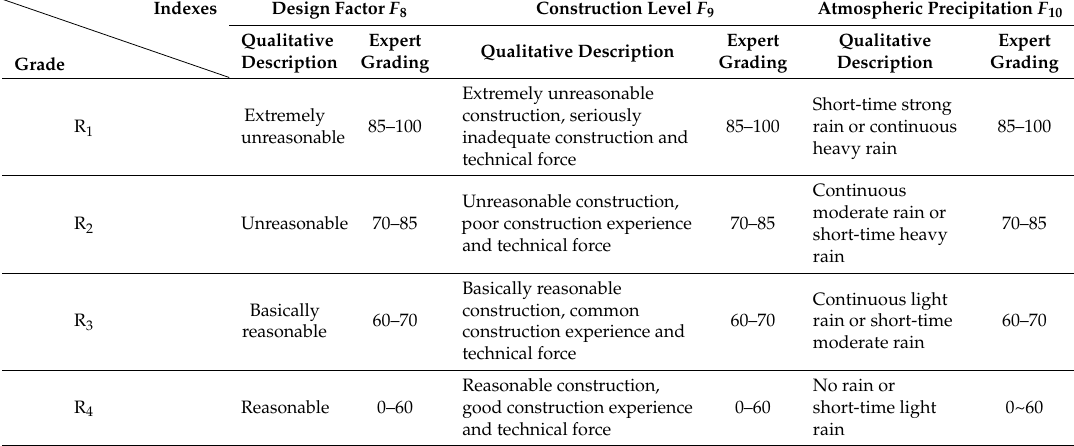
Table 4. Grade criteria of disaster-causing factors for water